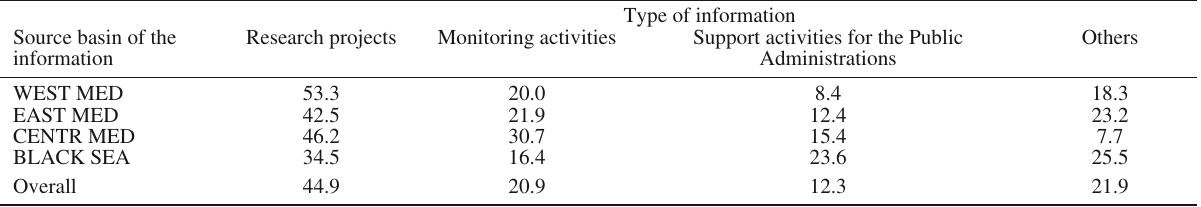
Table 2. – Classification of the information gathered according to the type of activity. The values reported are percentage contributions. The results are presented by main basins.